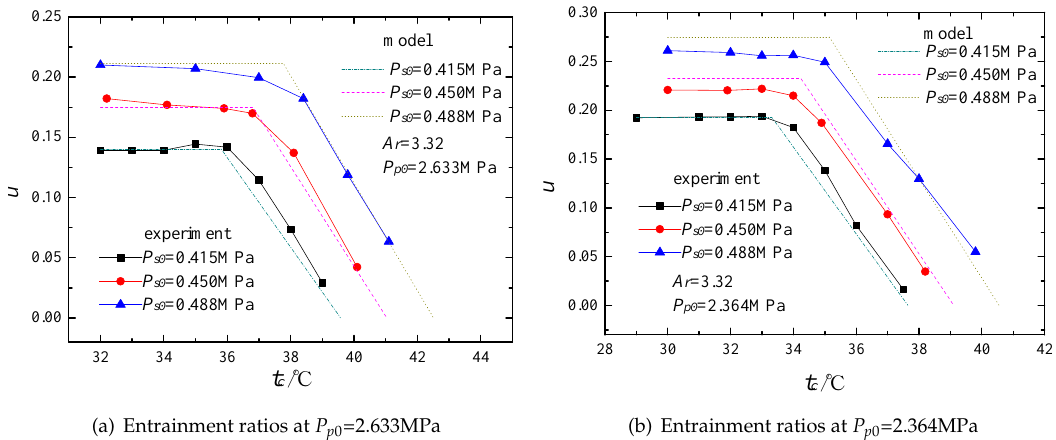
Figure 8. Comparisons of theoretical entrainment ratios with experimental values using R134a as a working